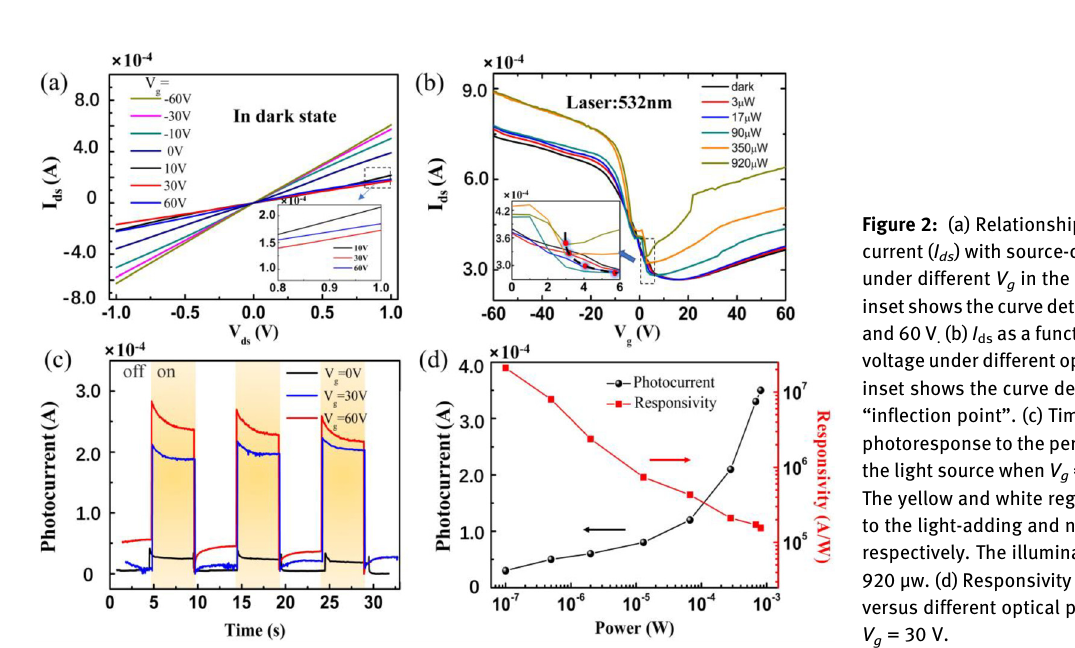
Figure 1: (a) Schematicview of the graphene/ silicon-on-insulator (GSOI) heterojunction device in photoconductive mode. (b) SEM image of the GSOI device. The monolayer graphenestrip(10 × 10µm)directlyattaches to the top-silicon, as shown in the dotted wireframe. (c) Energy band diagrams of the photodetector under positive vertical voltage. (d) Energy band diagrams of the photodetector under negative vertical voltage. Electrons and holes are denoted by blue and yellow circles, respectively.